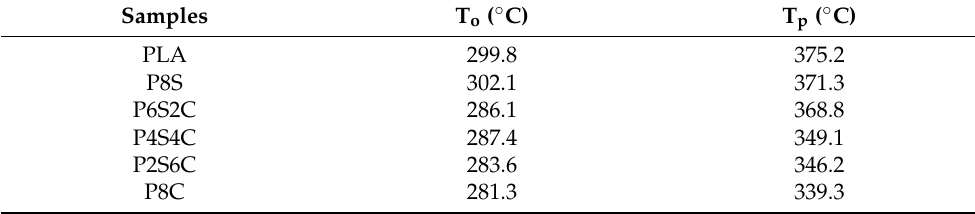
Figure 8. Thermogravimetry plot of the neat polylactic acid and biocomposites ( a ) Thermogravimetric analysis and ( b ) Derivative thermogravimetric analysis. Table 5. T.G. onset and DTG peak temperatures of the neat PLA and biocomposites.